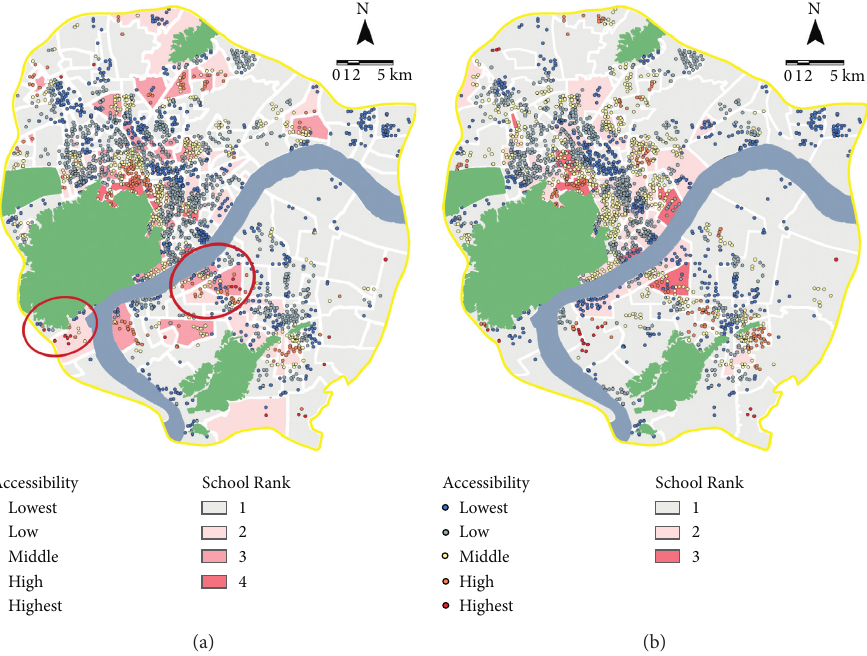
Figure 2: The distribution of education accessibility in Hangzhou with improved G2SFCA. (a) Primary school. (b) Secondary